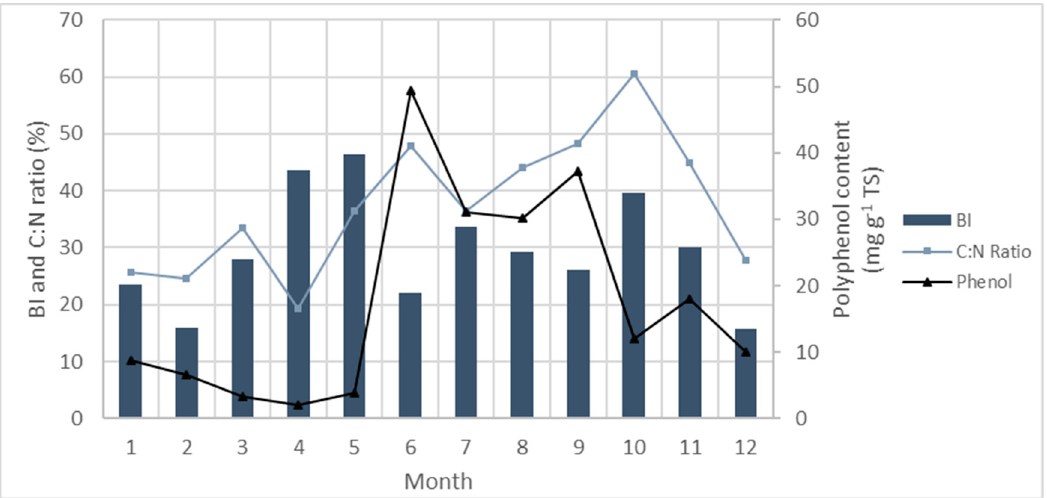
Figure 2. Annual variation in biodegradability index (BI) (BMP divided by theoretical methane yields), expressed in %, of A. nodosum with variations in polyphenol content and C:N ratio. Polyphenol content is expressed in mg g -1 total solids (TS). C:N ratio is expressed as the percentage of the sum of the ultimate analysis (C:N ratio divided by sum of % ultimate analysis). Figure derived from data by Tabassum, et al. [191].